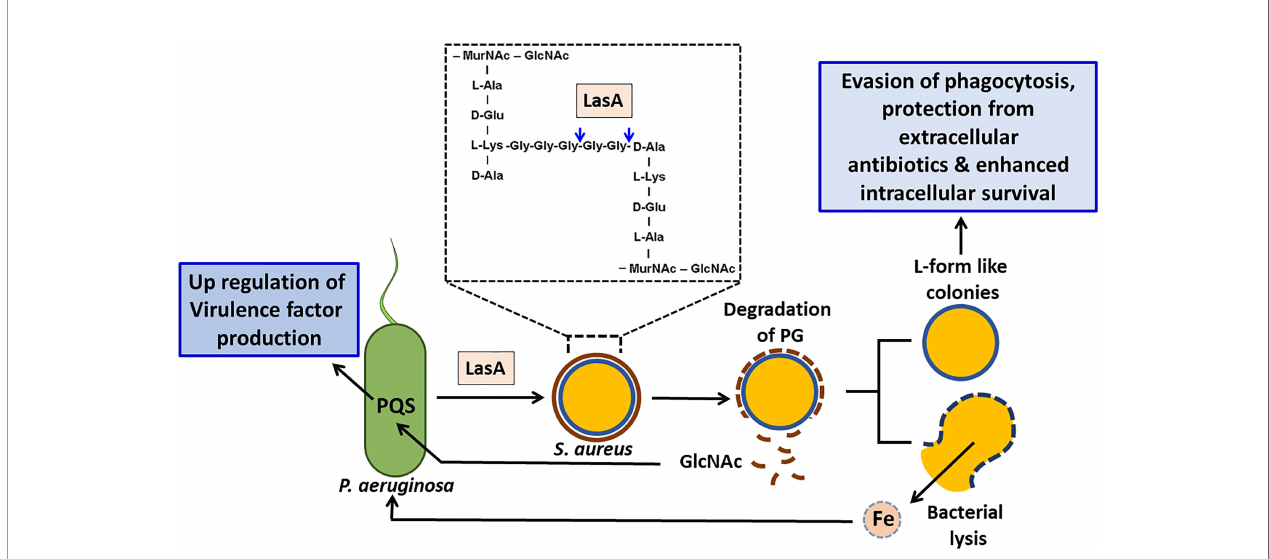
FIGURE 4 | Effect of staphylolysin (LasA) of P. aeruginosa on S. aureus. P. aeruginosa secreted staphylolysin (LasA) targets the glycyl-glycine and glycyl-alanine bonds of the pentaglycine cross-linkage in the peptidoglycan of S. aureus and induces its lysis. Lysed S. aureus cells could serve as a source of iron for P. aeruginosa thus promotes its growth. The N -acetyl glucosamine (GlcNAc) that is shed will be sensed by P. aeruginosa and enhances its PQS quorum sensing system and induces the production of extracellular virulence factors such as PYO, rhamnolipids and LasA etc that will aid in eliminating its competitors. S. aureus adapts the L-form like colonies to survive. In addition to surviving the effects of LasA, L-form like colonies confer several advantages to S. aureus such as evasion of phagocytosis, enhanced intracellular survival and protection from the effect of extracellular